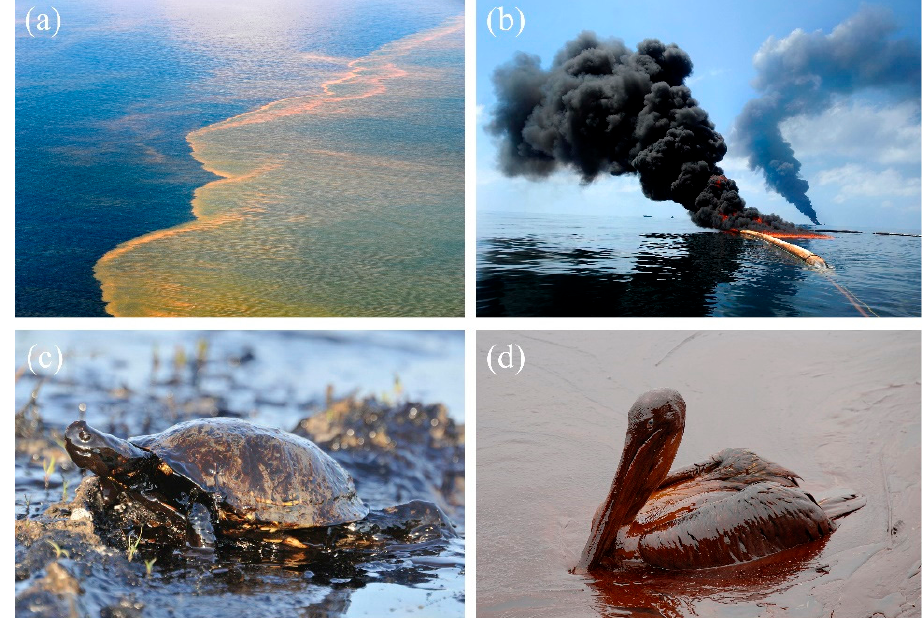
Figure 1. Gulf of Mexico oil spill event [7]: ( a ) marine ecosystems are polluted [10], ( b ) preventing the rapid spread of oil via oil fences and burning, and wide range of smoke causing serious air pollution [13]; reproduced with permission from the public domain in the United States. ( c and d ) the turtle [11] and brown pelican [12] contaminated with leaked crude oil on the sea; reproduced with permission from the Thinkstock and the Creative Commons Attribution-Share Alike 2.0 Generic.